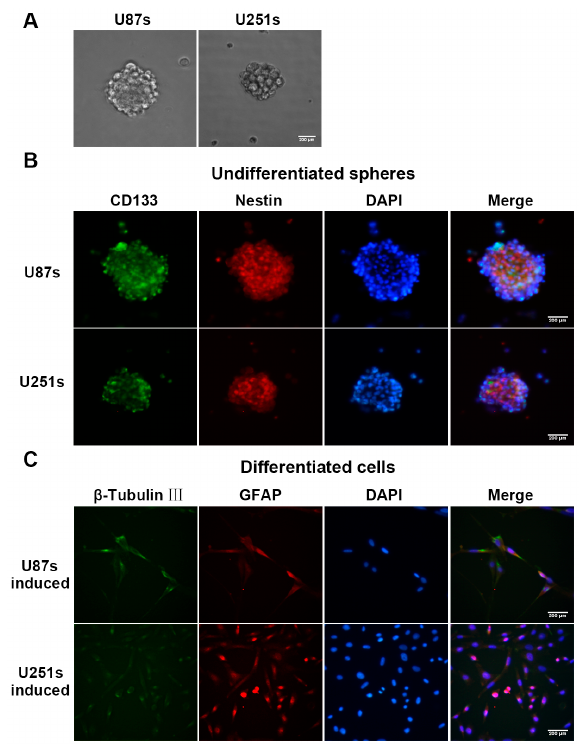
Figure 2. Isolation and identification of GSCs. ( A ) Representative images of primary GSCs; ( B ) Representative immunofluorescence staining images of CD133 (green) and nestin (red) in GSCs; ( C ) Representative immunofluorescence staining images of GFAP (red) and β -tubulin-III (green) in differentiated cells. Nuclei were counterstained with DAPI (blue) as a control. Images were photographed at 100× original magnification. All images are representative of three independent experiments images. Scale bar represents 200 µm.